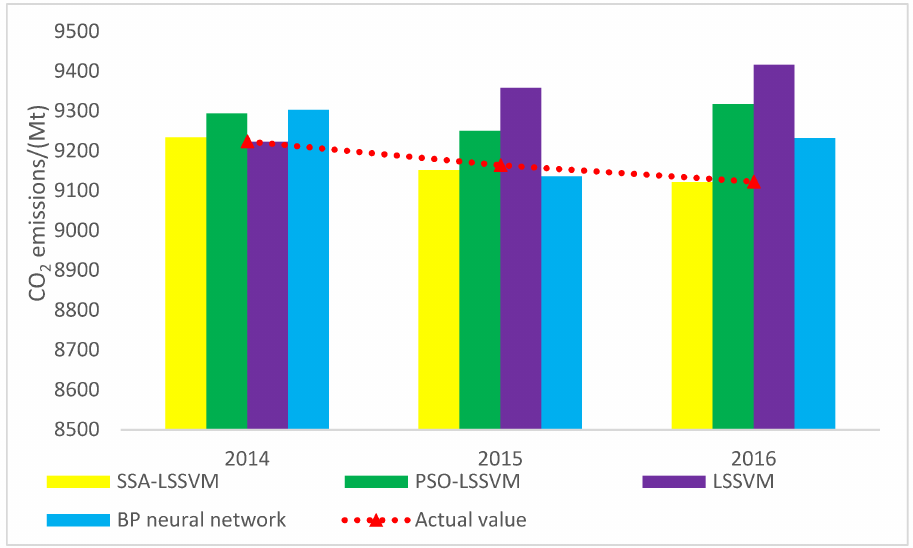
Figure 5. Forecasting values of CO 2 emissions from 2014 to 2016 in China by different